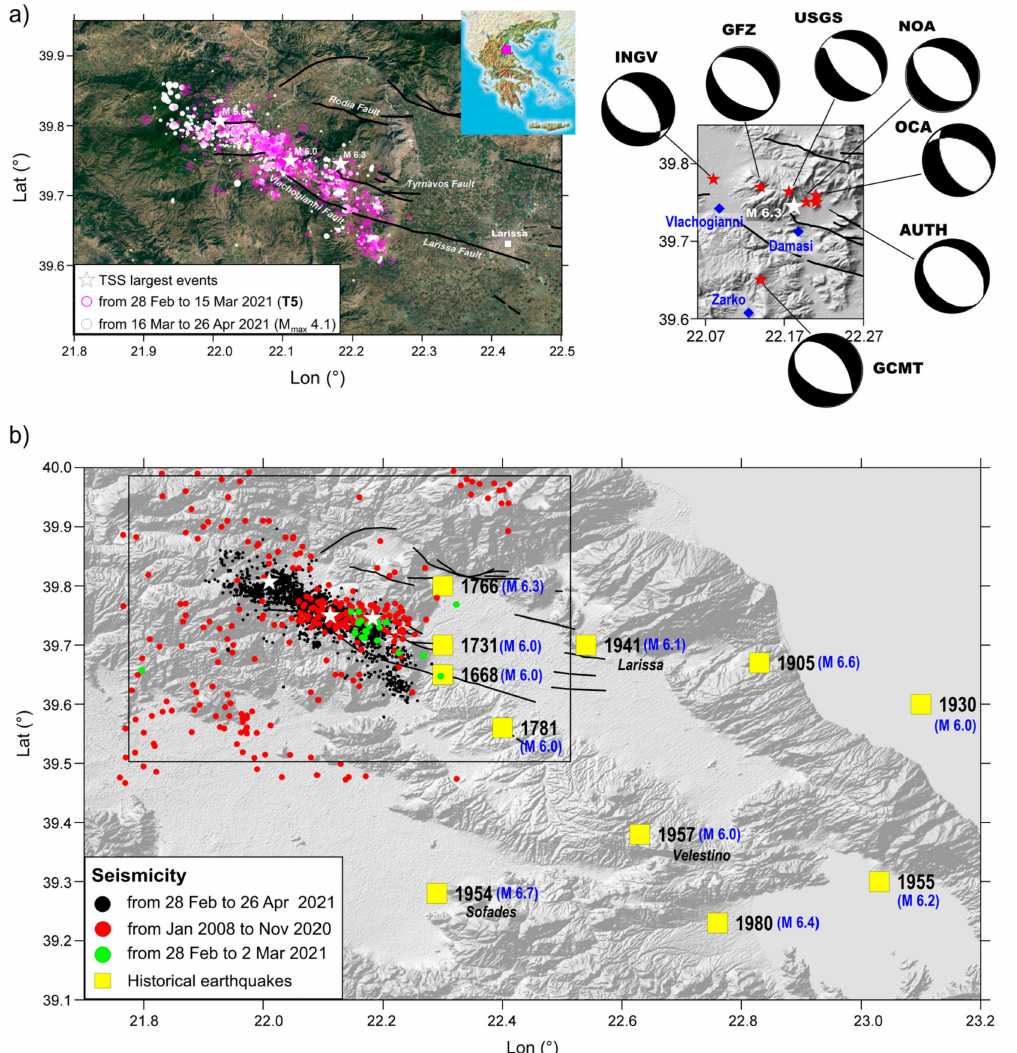
Figure 1. Study area and seismological data. ( a ; left) Main tectonic lineaments redrawn after [2] and represented by black lines; relocated earthquakes from 28 February 2021 to 15 March 2021 and from 16 March 2021 to 26 April 2021, represented by magenta and white circles, respectively. ( a ; right) Mw 6.3 epicentral area with focal mechanisms provided by various institutes; most damaged villages are also shown. ( b ) Recent recorded earthquakes in the Tyrnavos area. Historical earthquakes that occurred in Thessaly area are also shown (data by [3]). Recent earthquakes occurred in an area not covered by past events, thus filling a seismic